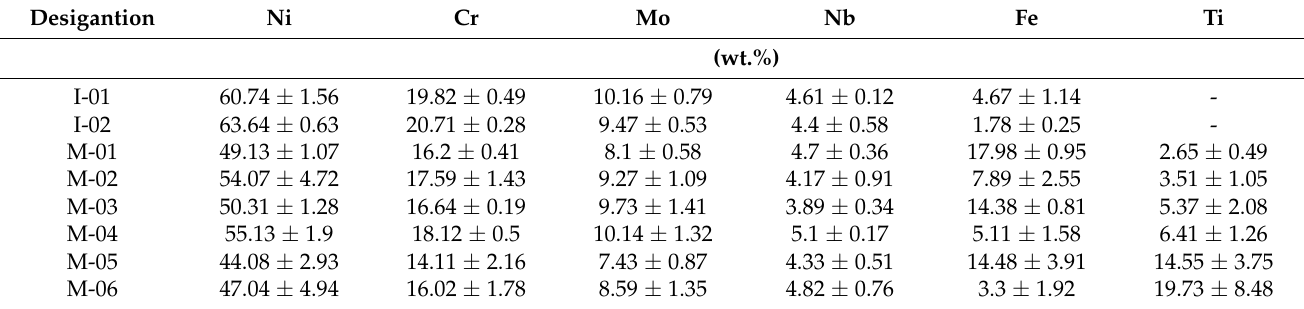
Figure 3. The penetrant test results of laser cladded Inconel 625/TiC coatings ( a ) I-01, ( b ) I-02, ( c ) M-01, ( d ) M-02, ( e ) M-03, ( f ) M-04, ( g ) M-05, ( h ) M-06 (coatings designation according to Table 3). Table 4. The produced coatings average chemical composition received from EDS surface